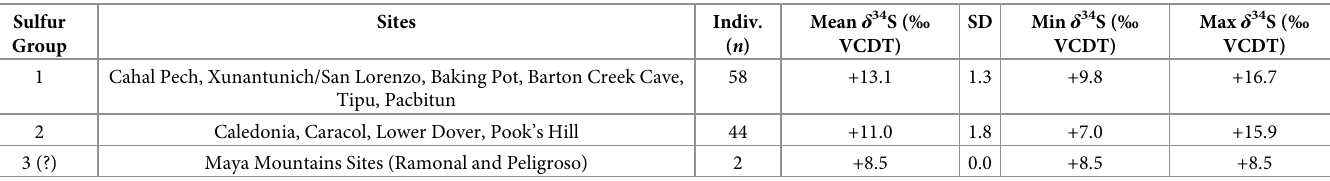
The minimum value for Group 2 does not include the extreme outlier from